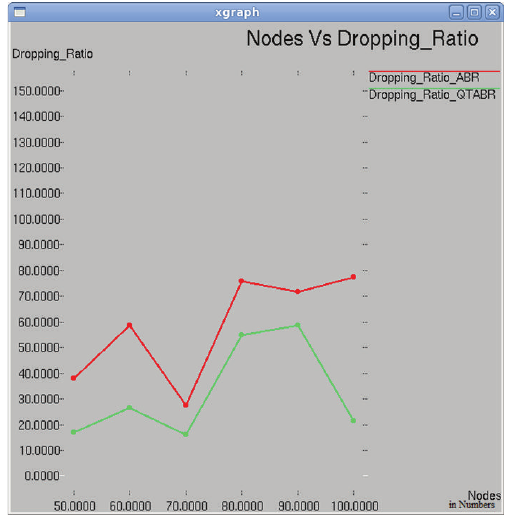
Figure 9: Speed versus PDR.